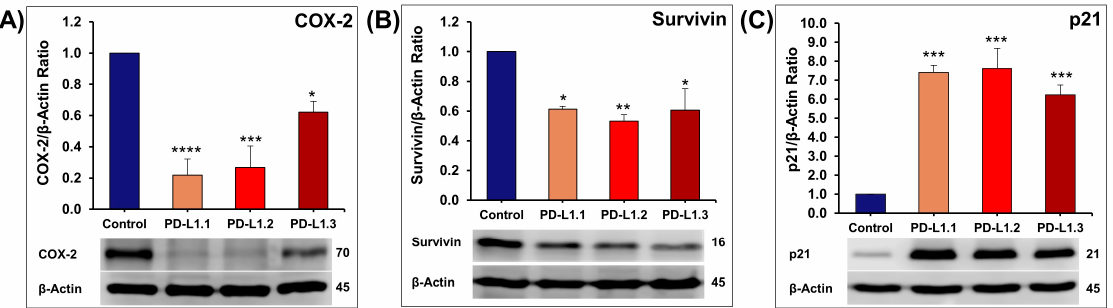
Figure 8. Quantification of the western blot showing the impact of PD-L1 knockout on the expression of COX-2 ( A ), Survivin ( B ), and p21 ( C ). Columns represent mean of at least three independent experiments; bars represent S.E.M. * p < 0.05. ** p < 0.01. *** p < 0.001. **** p < 0.0001.